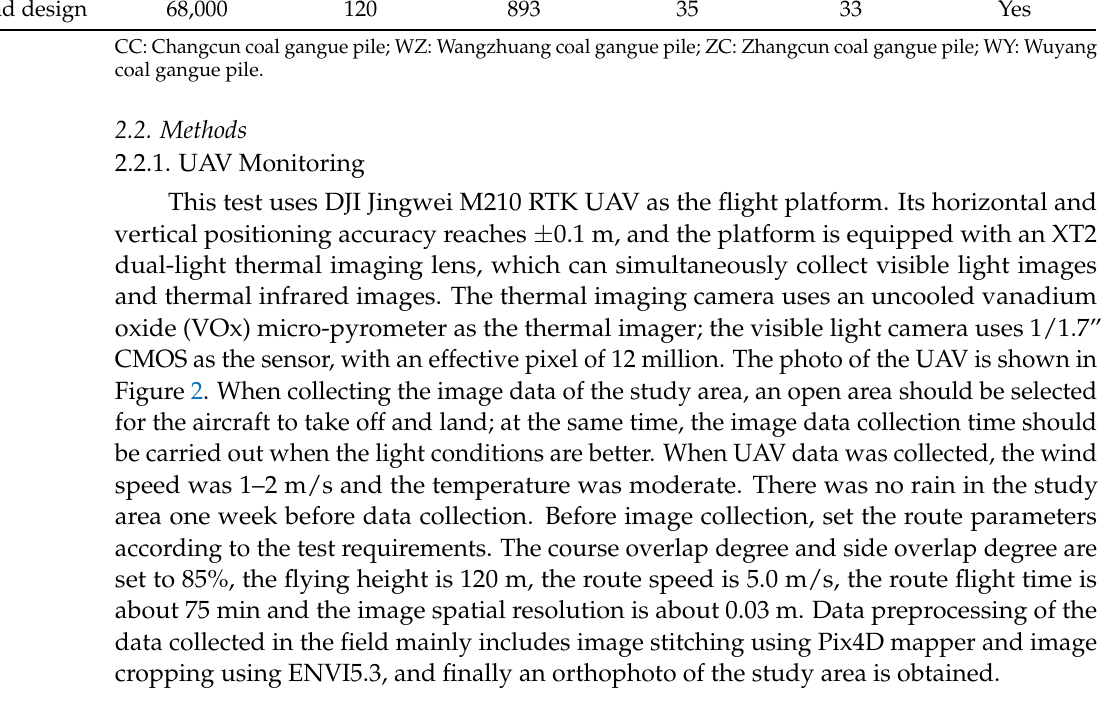
Table 1. Four research gangue pile questionnaires.